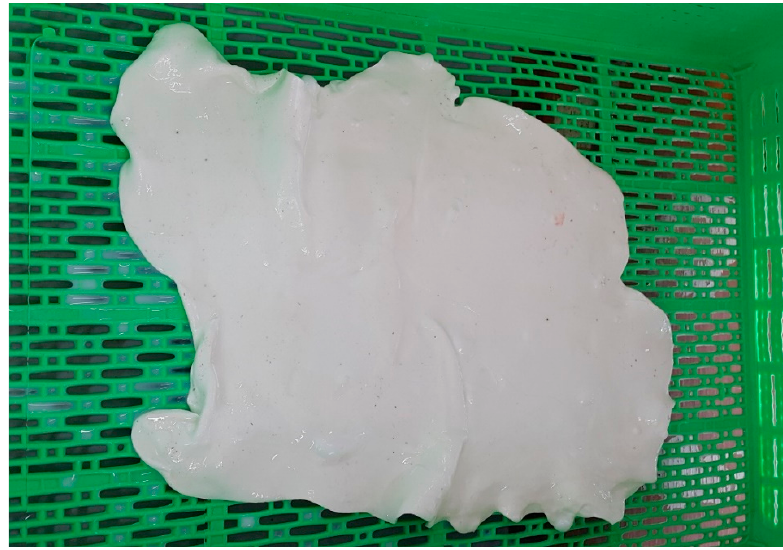
Figure 17. The determination of DRC in the natural latex samples.